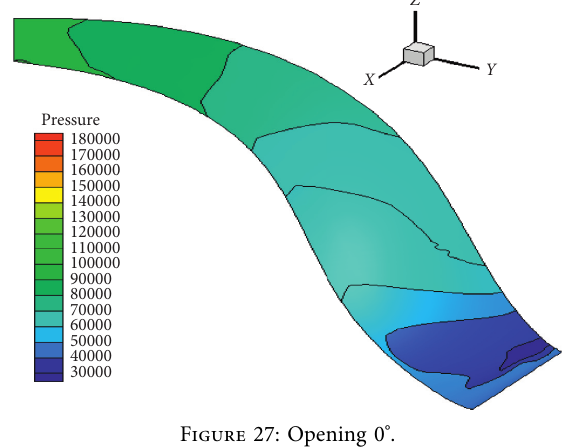
Figure 27: Opening 0 ° .